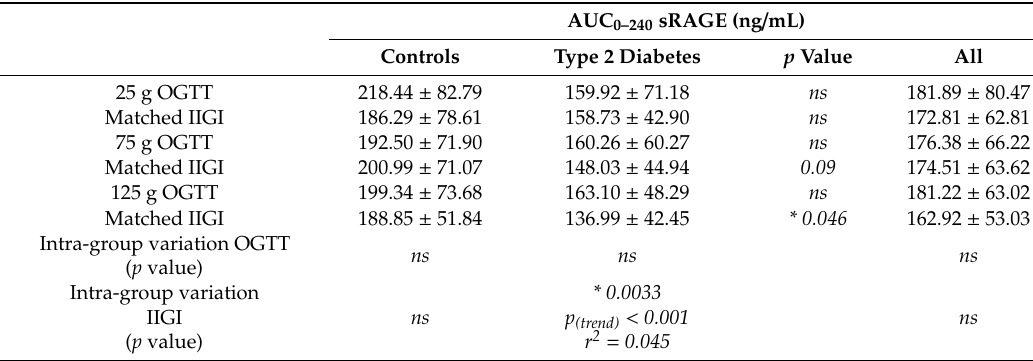
Table 2. Comparison of AUC 0–240 min for sRAGE during 25 g, 75 g and 125 g-OGTTs and corresponding